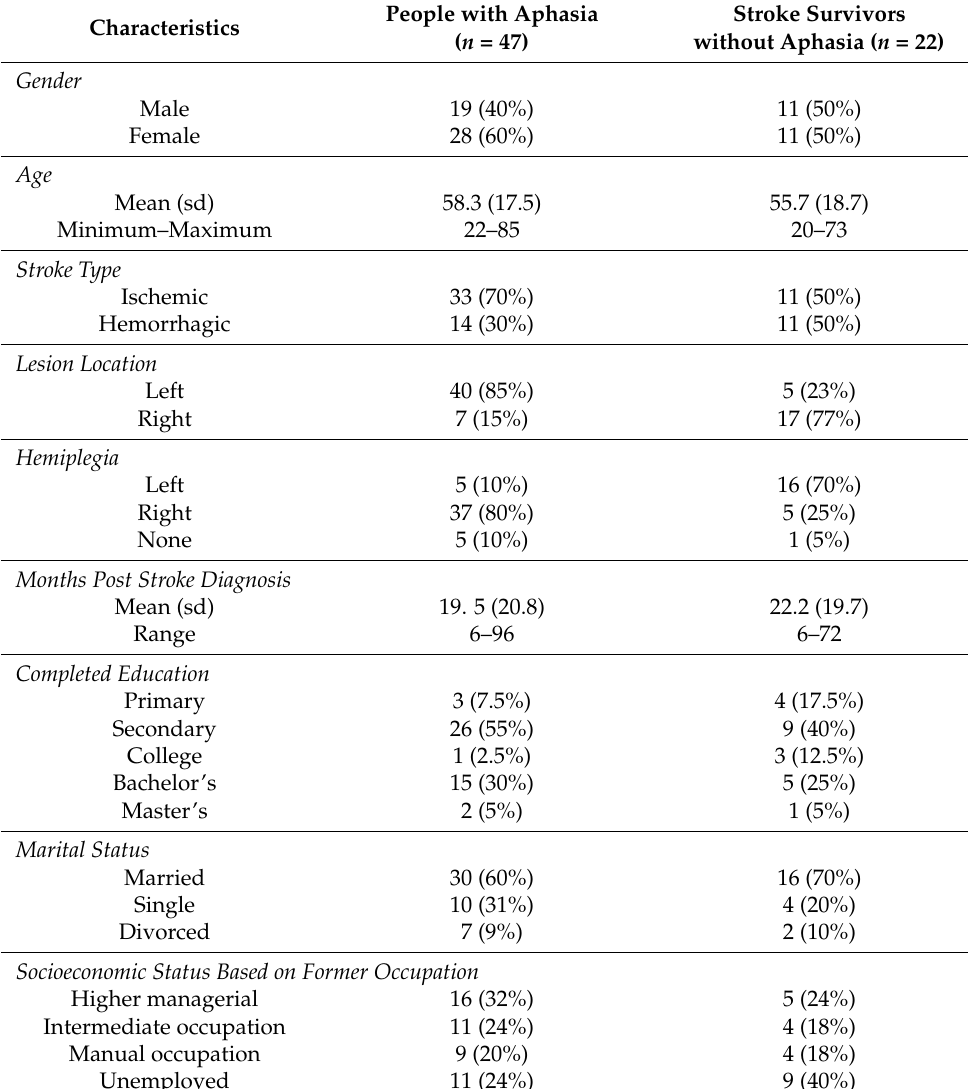
Table 2. Demographic data for participants with and without